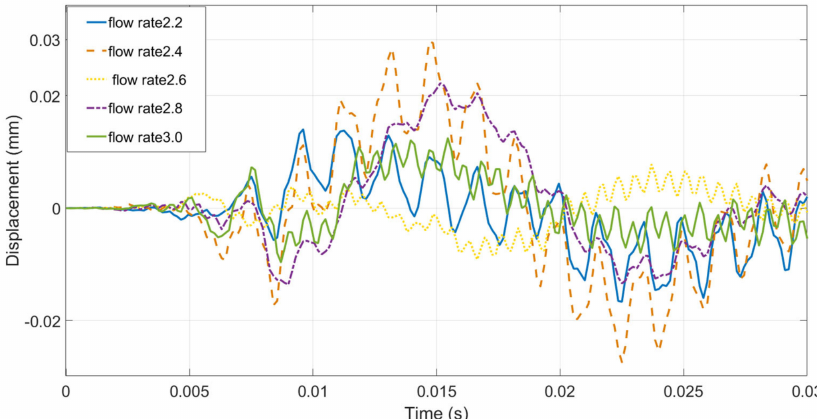
Figure 5. Displacement changing graph of sensor characteristic point C in Y direction under the impacts of different momentum jets.